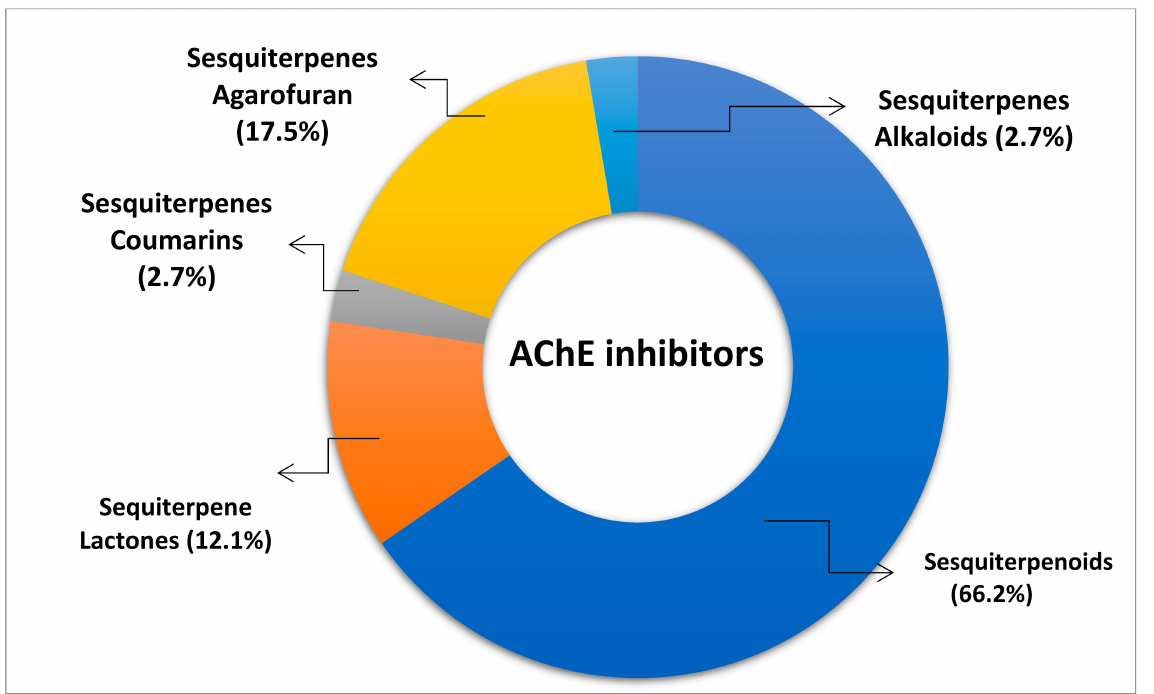
Figure 5. Percentage of various categories of sesquiterpenes with AChE inhibitory